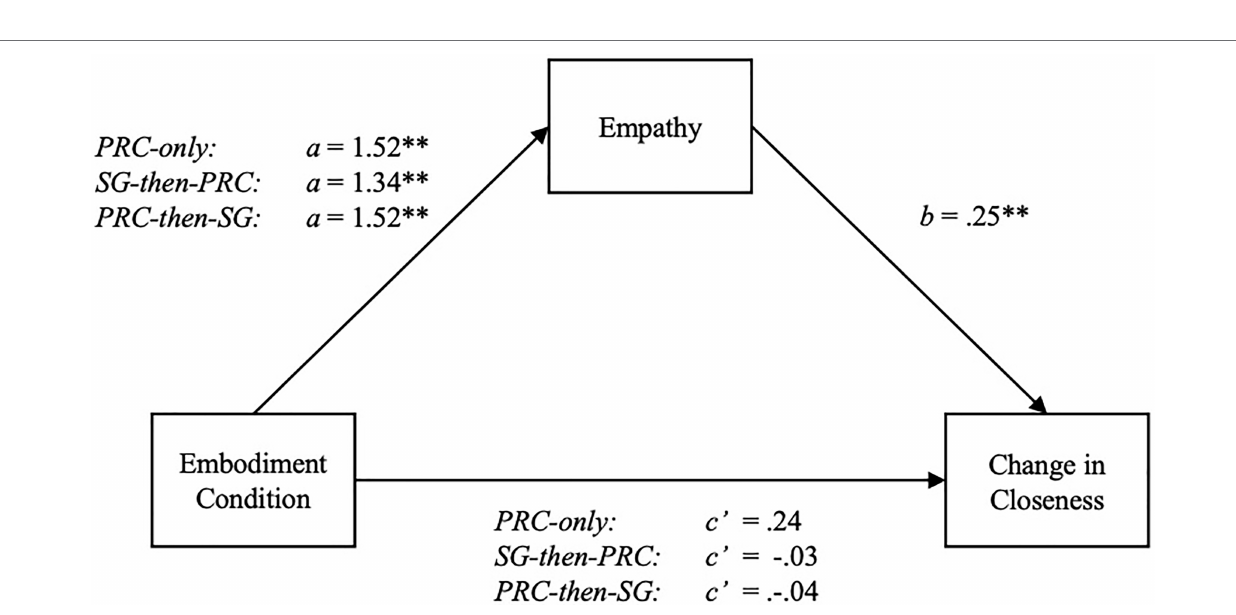
FIGURE 5 | Statistical model of empathy mediating the relative effects of embodiment condition on differences in self-other overlap (closeness). Coefficients are based on z-scored standardized values for empathy and self-other overlap change scores. * p < 0.05; ** p <